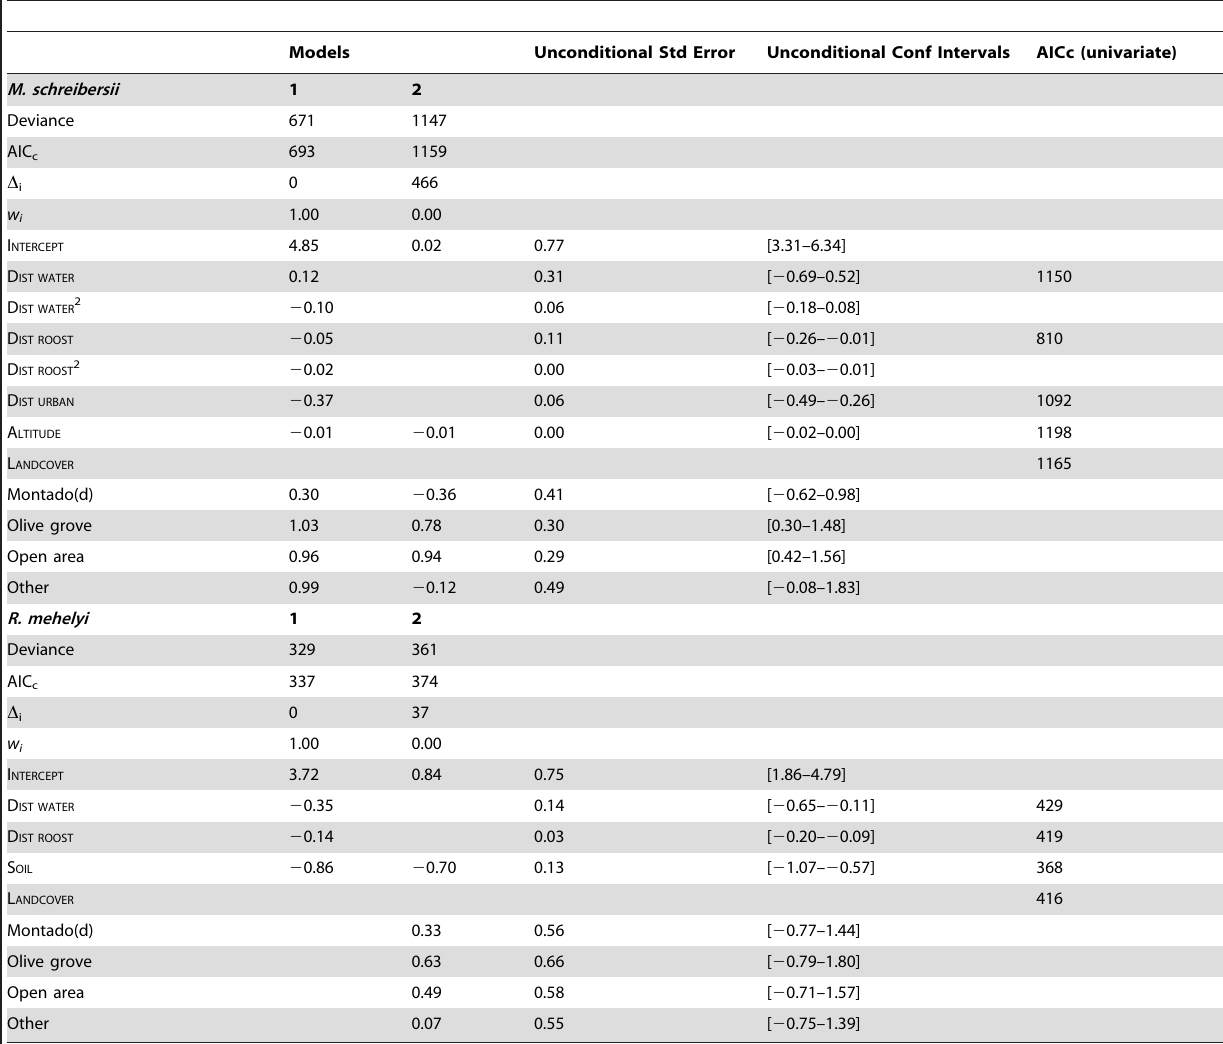
Table 1. Best candidate habitat suitability models for the foraging data of Miniopterus schreibersii (top) and Rhinolophus mehelyi (bottom) based on an information-theoretic approach using the Akaike information criterion for small samples